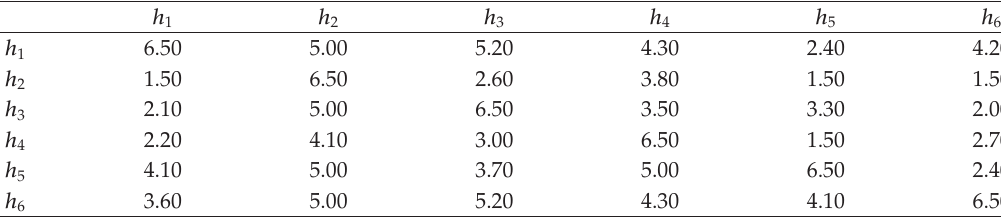
Table 5: The generalised comparison table about (cid:2) G β .